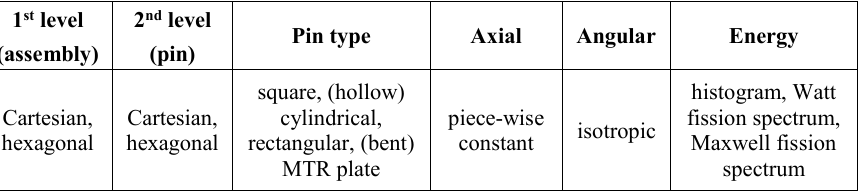
Table 1 : Fixed neutron source options available in the new routines. Axial distributions may have different axial discretization per assembly. Energy distributions can be combined freely.